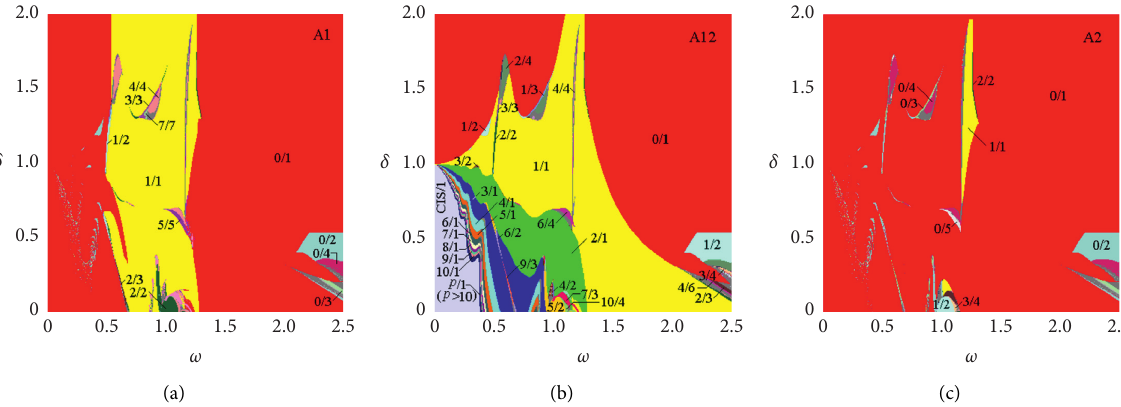
Figure 17: Periodic motions on the ( ω , δ ) -parameter plane associated with each constraint when δ (b) constraint A 12 ; (c) constraint A 2 .